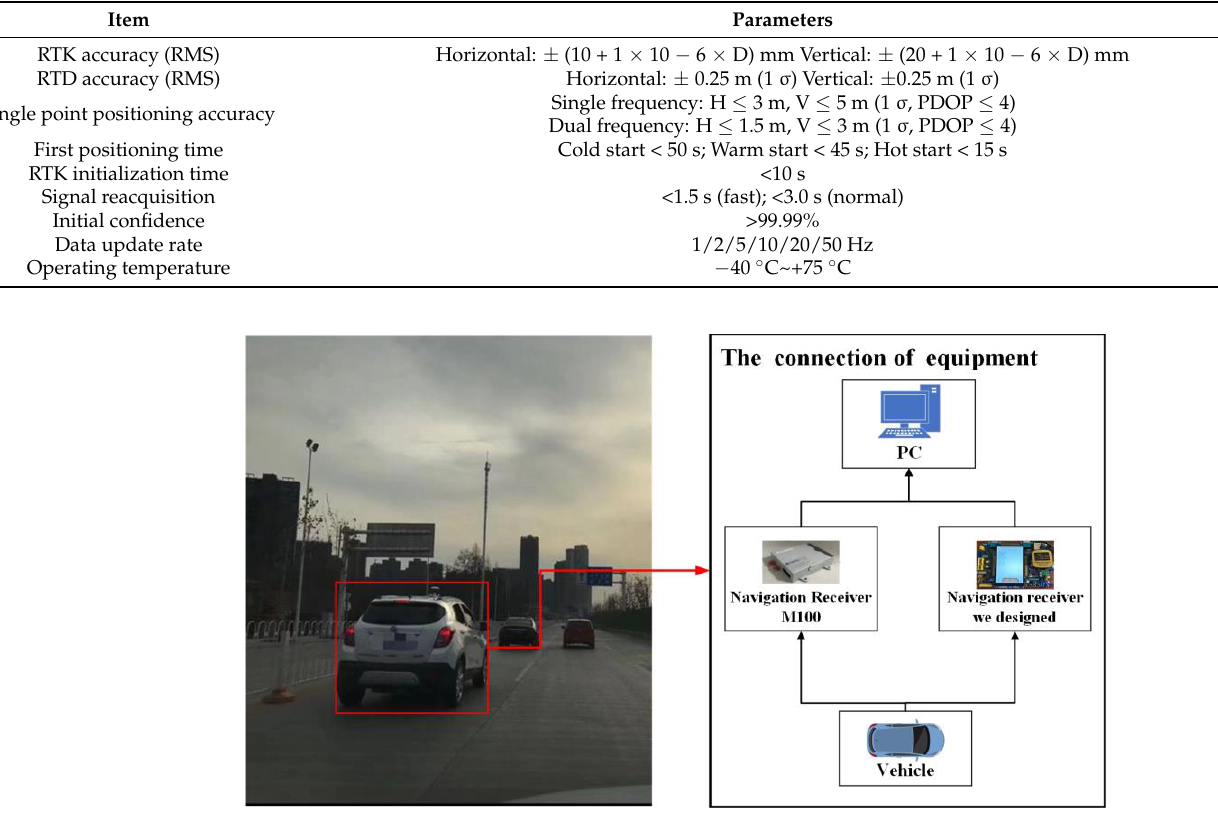
Figure 6. The connection of the test equipment. Table 2. Parameters of M100 receiver